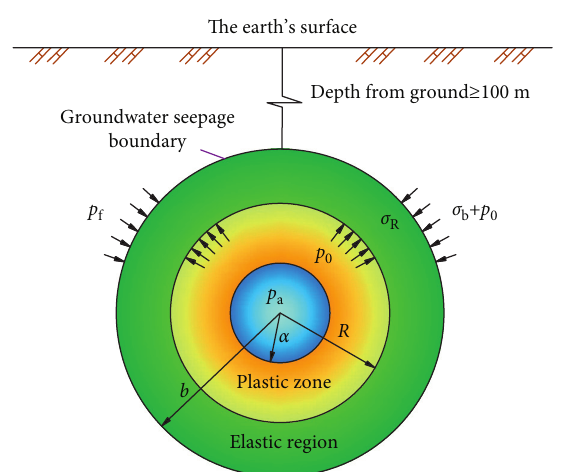
Figure 2: Mechanical calculation